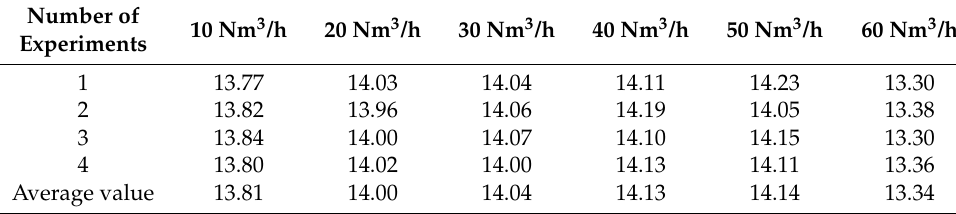
Table 9. Liquid particle size in Case 2 at M 2 ( µ m).